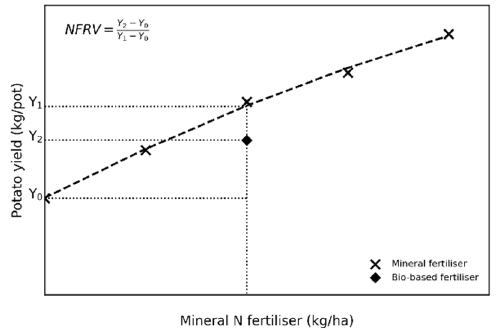
Figure 1. Calculation of the nitrogen fertiliser replacement value (NFRV) using the response yield curve method (adapted from [24]).